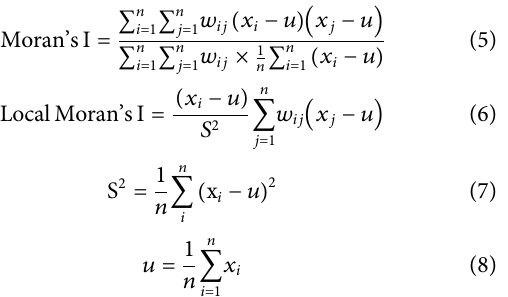
autocorrelation (LISA) and Moran scatterplots. The formulas